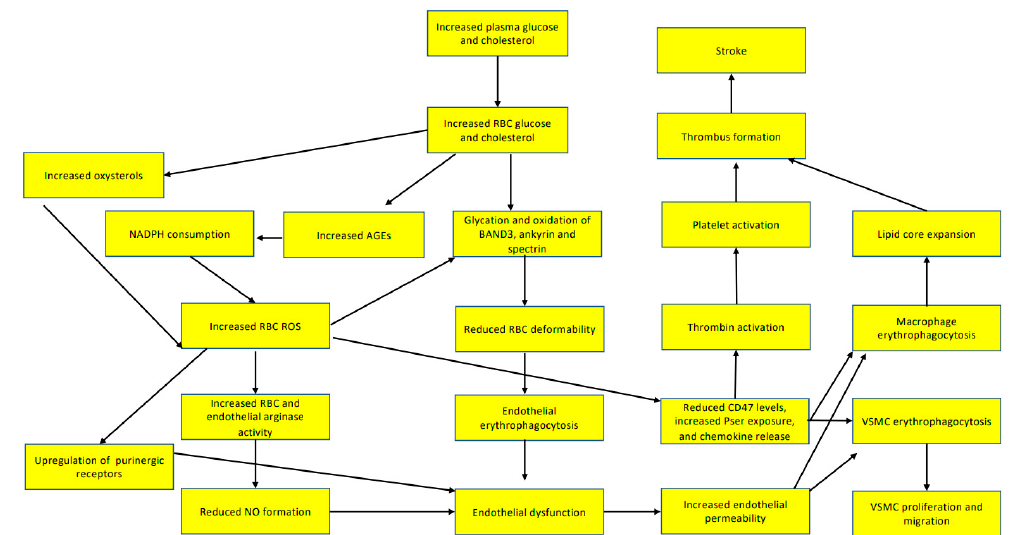
Figure 1. Risk factors for atherothrombosis, such as dyslipidemia and hyperglycemia, act on circulating red blood cells. Both high glucose and high cholesterol result in impaired erythrocyte antioxidant capacity. This leads to protein and lipid oxidation, subsequently lowering membrane deformability. In addition, reactive oxygen and nitrogen species drive arginase activity upregulation and programmed erythrocyte death (eryptosis). Erythrocytes are recognized by endothelial cells through their exposed phosphatidylserine and advanced glycation end products. In addition, erythrocyte-derived reactive oxygen species (ROS) upregulate purinergic receptors on endothelial cells. These events lead to endothelial activation and permeability. Permeable and activated endothelial cells allow monocytes and neutrophils to enter the arterial wall. Red blood cells also infiltrate and are phagocytized by macrophages and vascular smooth muscle cells. The release of chemokines and sphingosine 1-phosphate, along with exposed phosphatidylserine and reduced cluster of differentiation 47 (CD47) membrane levels, drive erythrophagocytosis. High cholesterol levels in erythrocytes facilitate the formation of foam cells, contributing to the expansion of the necrotic lipid core, while vascular smooth muscle cells (VSMCs) migrate and multiply. Exposed phosphatidylserine contributes to platelet activation, while erythrocyte CD47 molecules interact with fibrinogen. These events lead to atherothrombosis. Atherothrombosis restrains oxygen supply to the brain, causing an ischemic stroke. CD47: cluster of differentiation 47; NO: nitric oxide; RBC: red blood cells; ROS: reactive oxygen species; VSMCs: vascular smooth muscle cells The Figure was partly generated using Servier